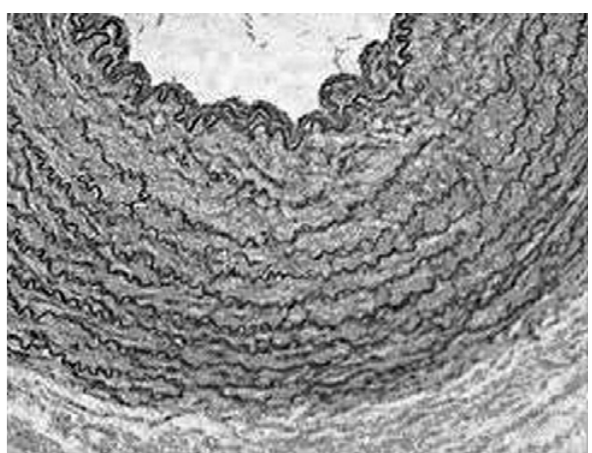
Fig. 2 - Fotomicrografia ilustrativa de segmento da ATIE corado com a técnica de Verhoeff-Van Gieson (magnificação de 200x)